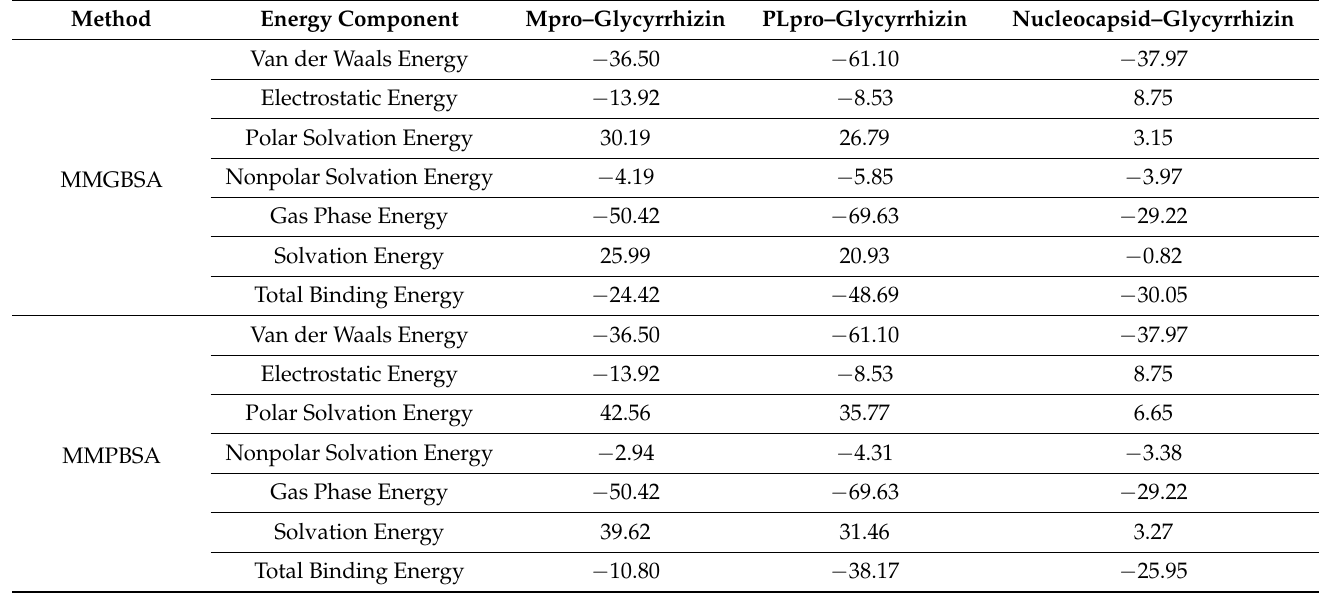
Table 1. Binding free energy components of SARS-CoV-2 enzyme complexes with glycyrrhizin. The energy values are provided in units of